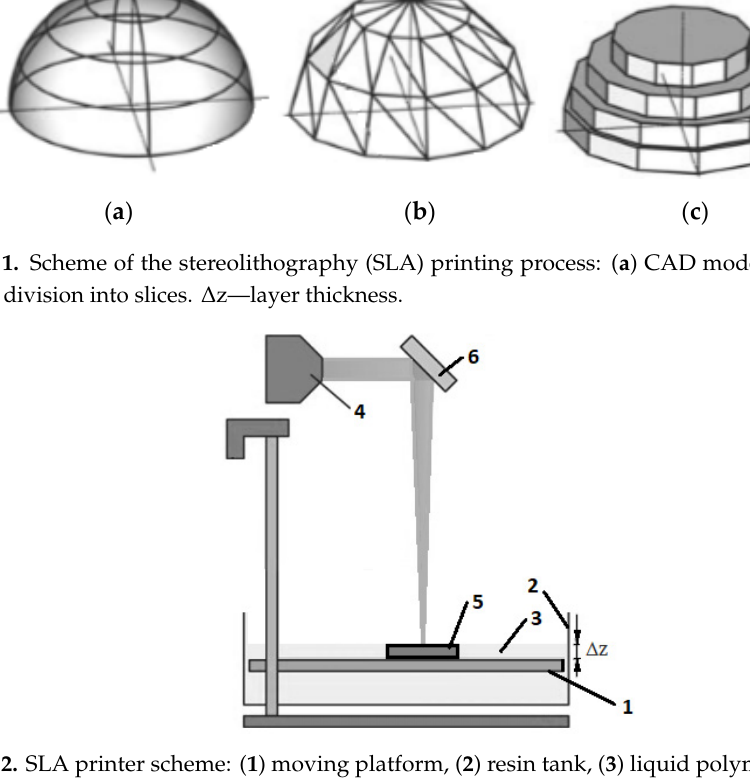
Figure 2. SLA printer scheme: ( 1 ) moving platform, ( 2 ) resin tank, ( 3 ) liquid polymer, ( 4 ) ultraviolet (UV) laser, ( 5 ) printed object, ( 6 ) mirror. Δ z—layer thickness.